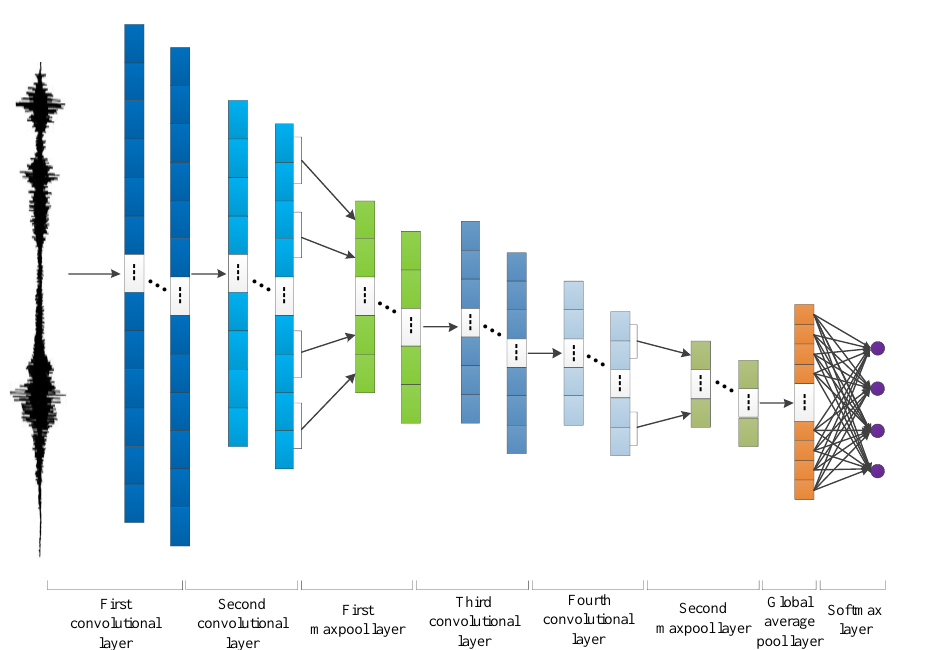
Figure 2. One-dimensional convolutional neural network structure diagram.